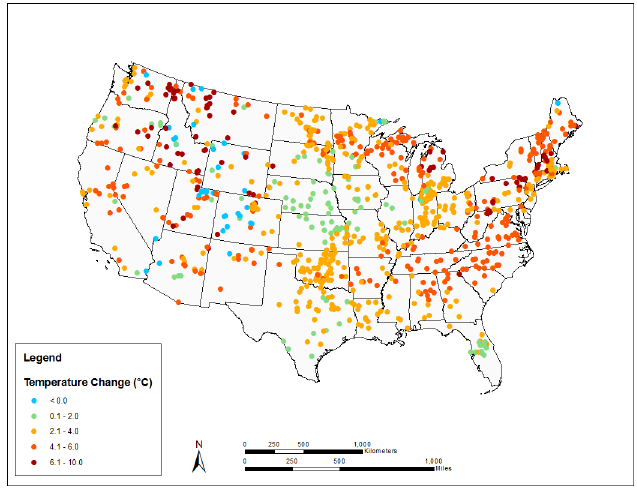
Fig 4. Simulated changes in summer MWATs above the thermocline for NLA lakes, ca. 2085 (median across climate scenarios).